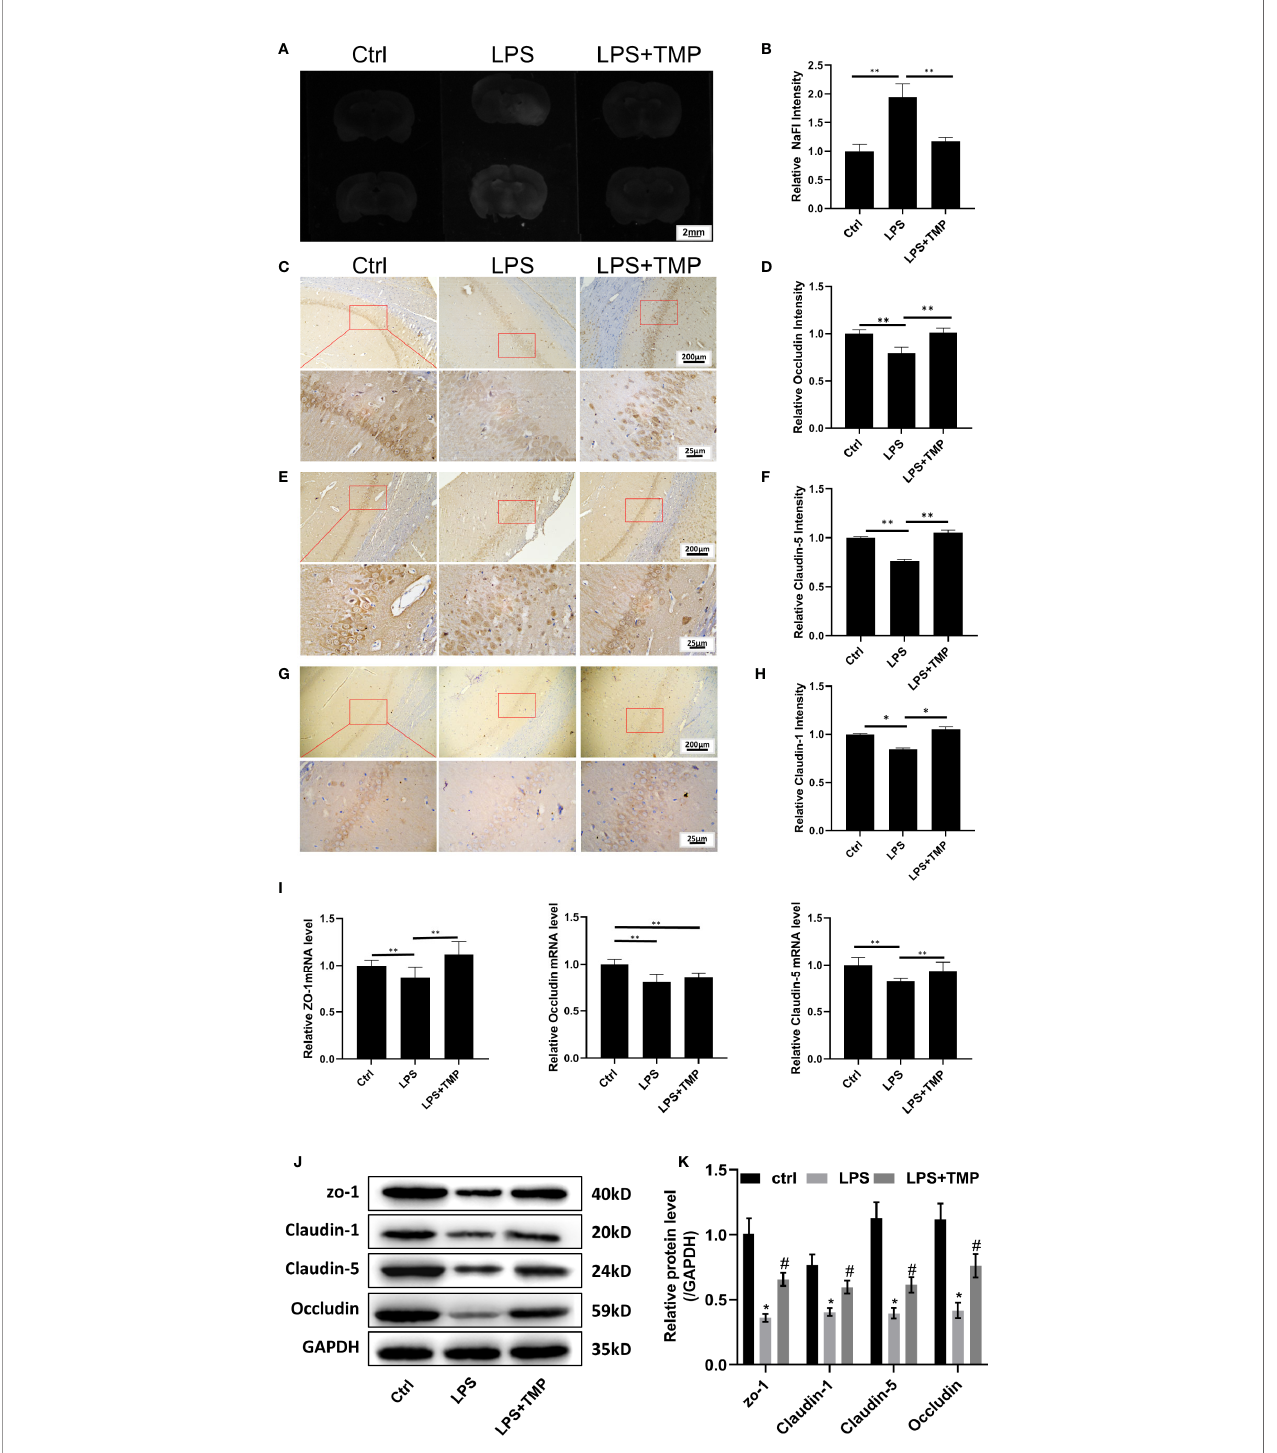
FIGURE 4 | TMP has a protective effect on the LPS-induced BBB destruction in sepsis. (A) Sodium fl uorescein staining revealed the degree of blood – brain barrier damage, and the images were taken by a UV gel imager. (B) The relative intensity of the Sodium fl uorescein signaling is calculated. (C) IHC staining of the occludin in hippocampus of the rats (Upper, 100×; Lower, 400×). (D) The relative IHC intensity of occludin protein; (E) IHC staining of the Claudin-5 in hippocampus of the rats (Upper, 100×; Lower, 400×). (F) The relative IHC intensity of Claudin-5 protein; (G) IHC staining of the Claudin-1 in hippocampus of the rats (Upper, 100×; Lower, 400×). (H) The relative IHC intensity of Claudin-1 protein; (I) The relative levels of the ZO-1 , O ccludin , and Claudin-5 genes in the brains of each group ( n =8). (J – K) Western blot results and Histogram shows statistical quanti fi ed results. Compared with the LPS group, * P < 0.05, ** P < 0.01. Compared with the Control group, # P <